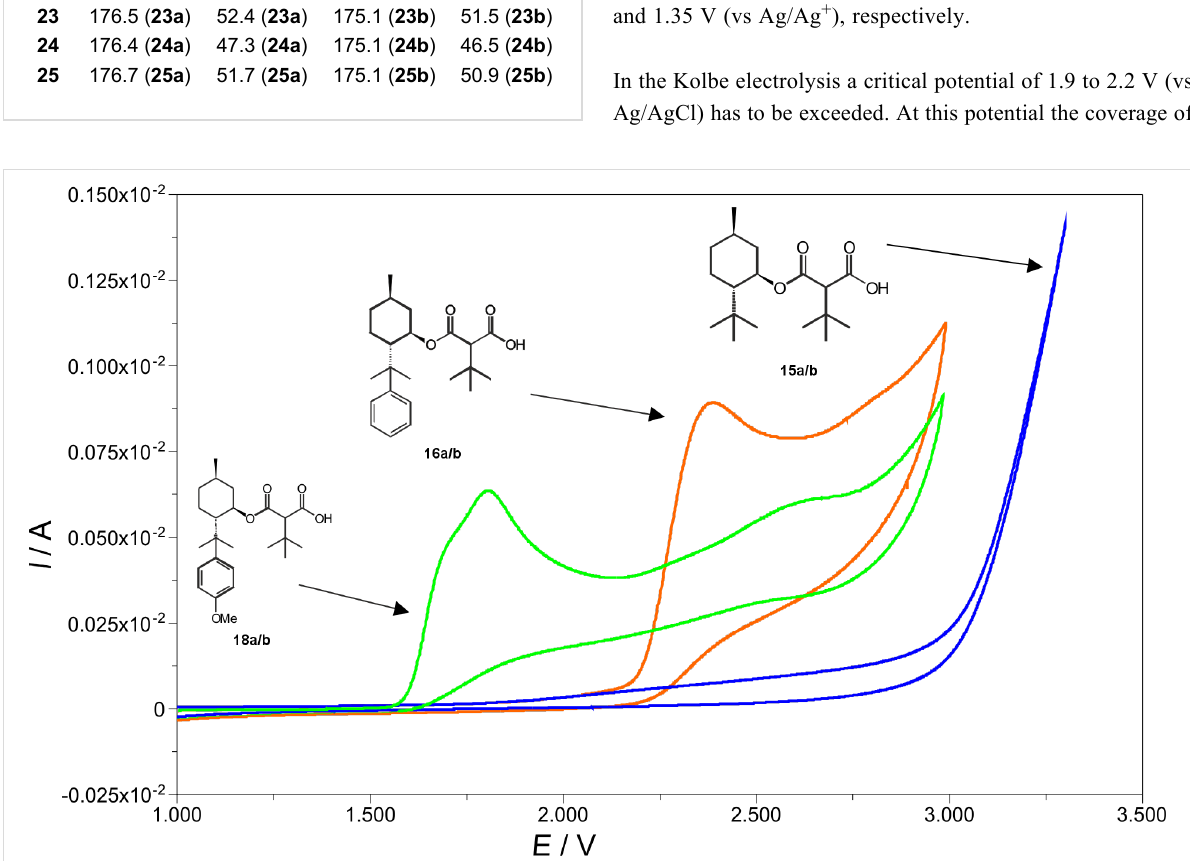
Figure 3: Cyclic voltammograms of the malonic derivatives 15a/b , 16a/b and 18a/b (scan rate: 500 mA/s, solvent: acetonitrile, supporting electrolyte: tetrabutylammonium perchlorate (TBAClO 4 ), reference electrode: Ag/AgCl).